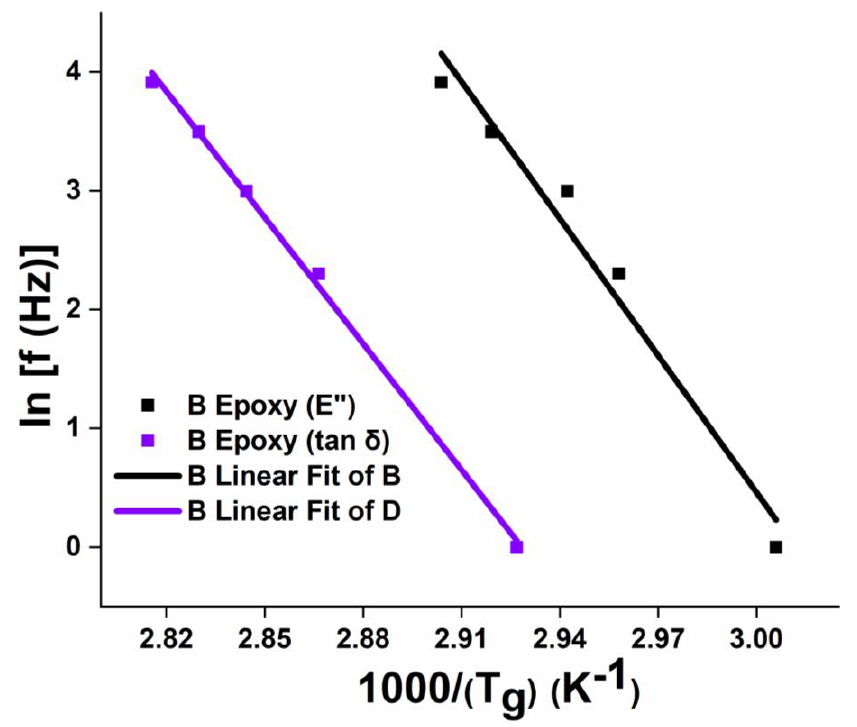
Figure 16. Effect of frequency on T g ((E”) max ) and T g ((tan δ) max ) of epoxy. Figure 16. E ff ect of frequency on T g ((E”) max ) and T g ((tan δ ) max ) of